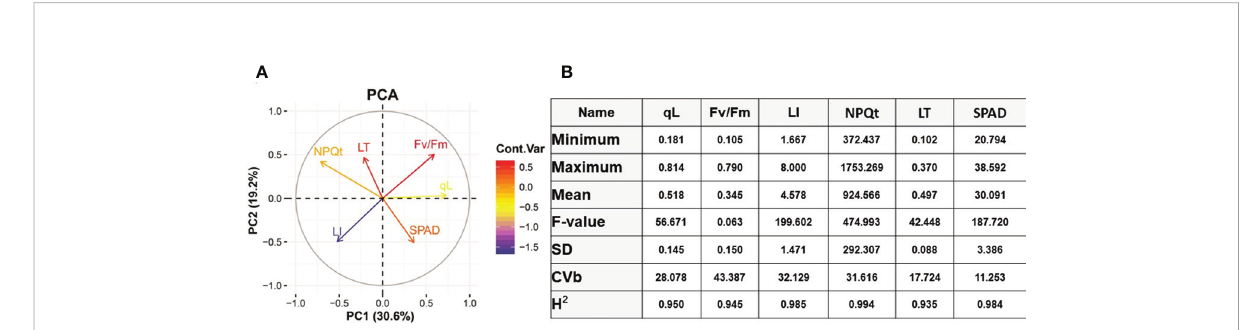
FIGURE 1 PCA analysis and Basic statistical analysis. (A) PCA analysis of different traits. (B) Analysis of Variance (ANOVA). qL, Fv/Fm, Non-photochemical quenching (NPQt), LI= leaf injury, LT=Leaf thickness, SD= standard deviation, CVb= coef fi cient of variation, H 2 = Heritability, GA= Genetic